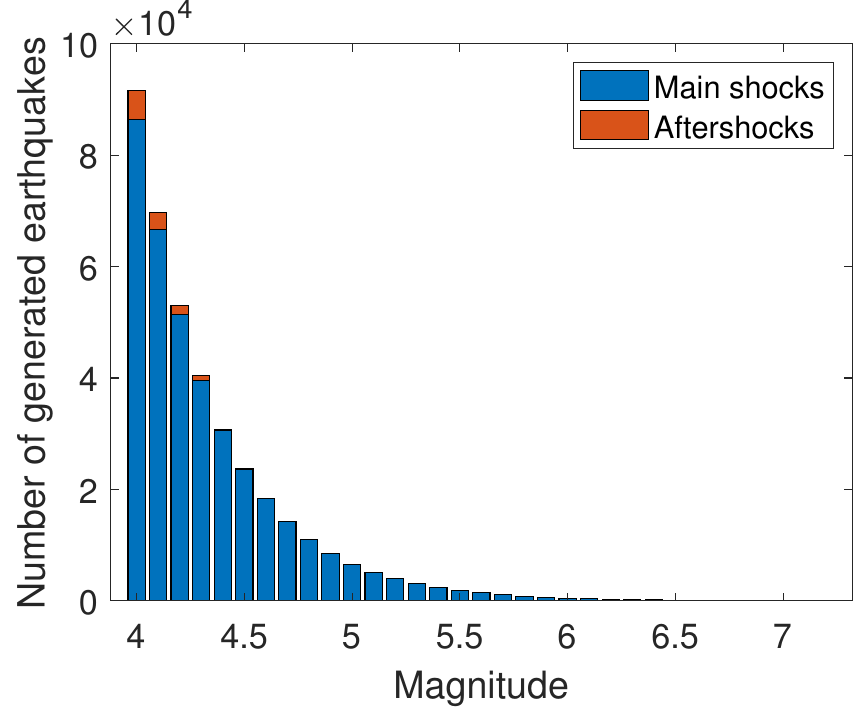
Figure 11. Number of main shocks and aftershocks generated over 100,000 years as function of